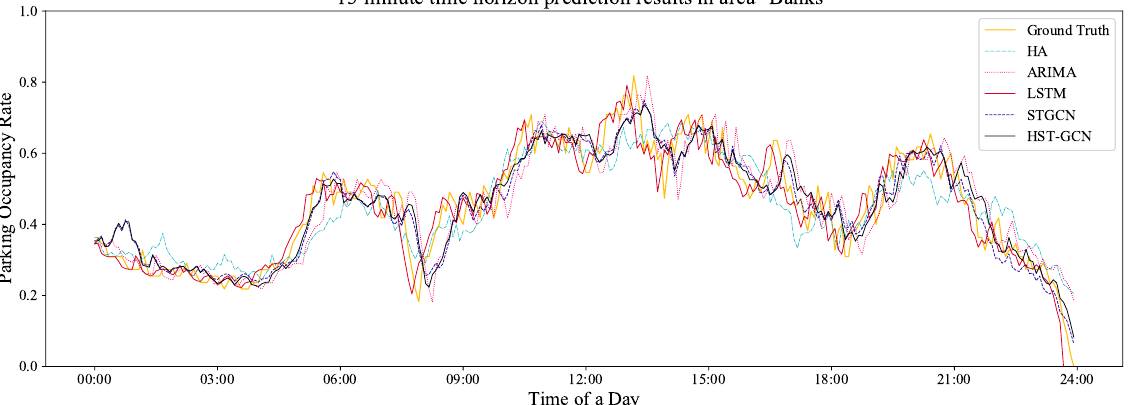
Figure 7. The prediction of a randomly selected area with a 15-min time horizon.